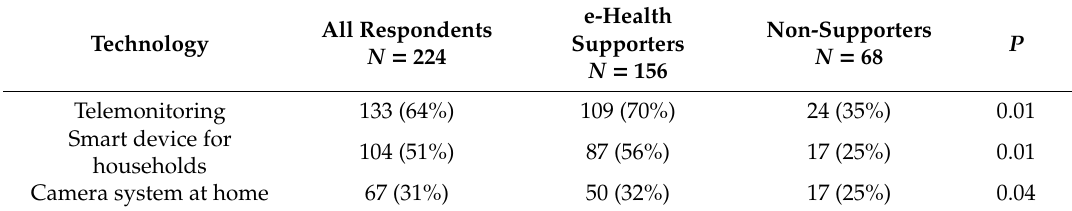
Table 5. Preference for telemonitoring and smart e-Health